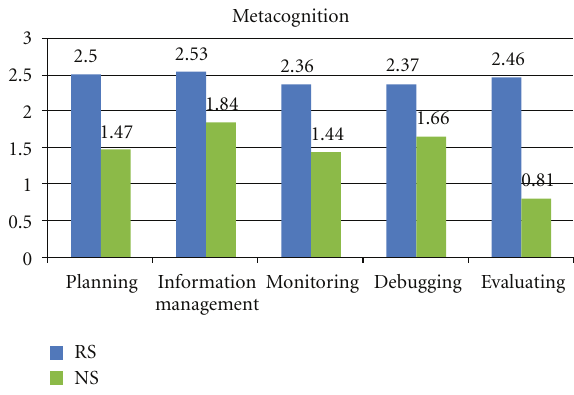
Figure 1: Metacognition level according to reflective support/no support for SRL.